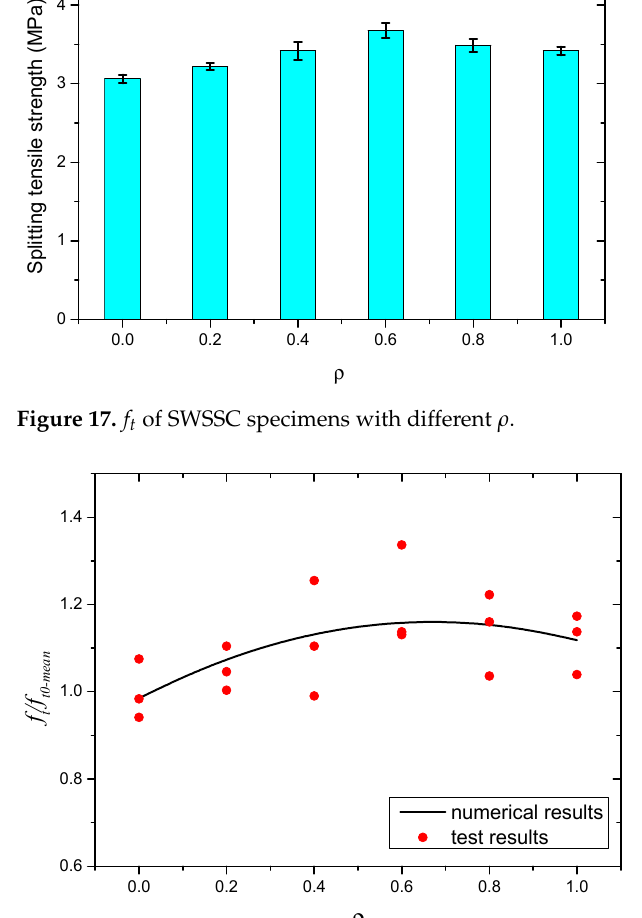
Figure 18. Comparison between numerical and test results: f t .